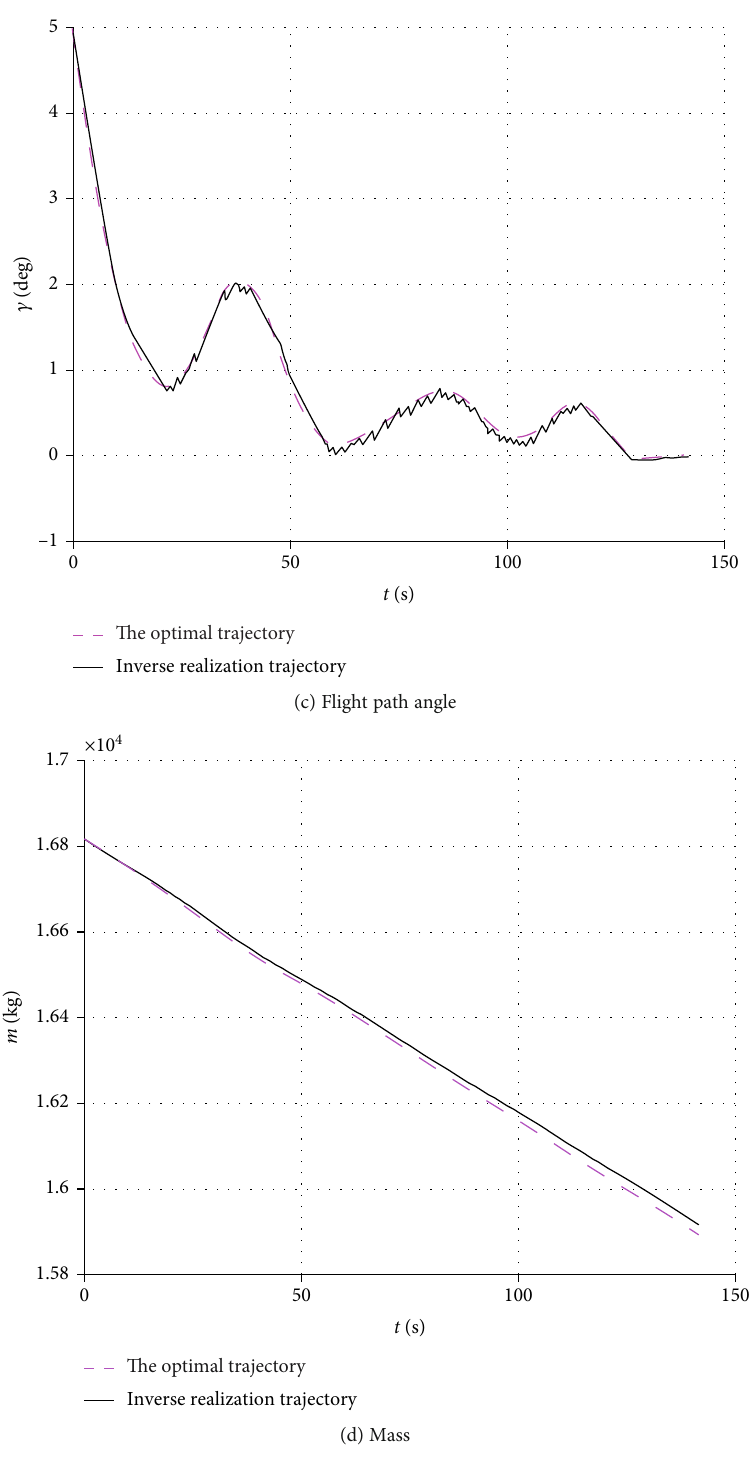
Figure 9: Comparison between actual trajectory and optimal